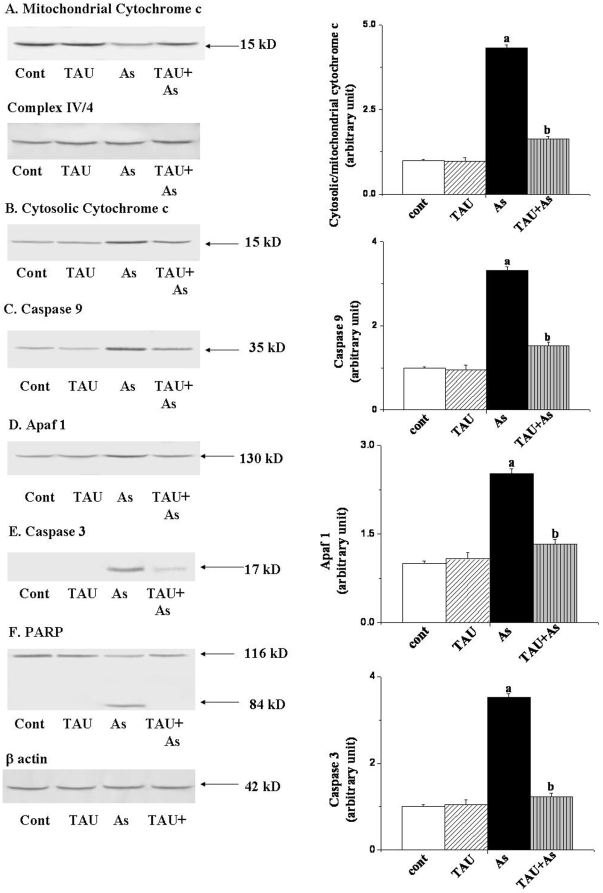
Immunoblot analysis on Mitochondrion-dependent pathway in absence (As) and presence of taurine (TAU+As).Panel A: Mitochondrial cytochrome c, complex IV subunit was used as loading control. Panel B: Cytosolic cytochrome c, Panel C: Caspase 9, Panel D: Apaf 1, Panel E: Caspase 3, Panel F: PARP. β actin was used as an internal control. Data represent the average ± SD of 6 separate experiments in each group. “a” indicates the significant difference between the normal control and As treated groups, “b” indicates the significant difference between the As treated and taurine treated groups (TAU+As). (Pa<0.05, Pb<0.05).